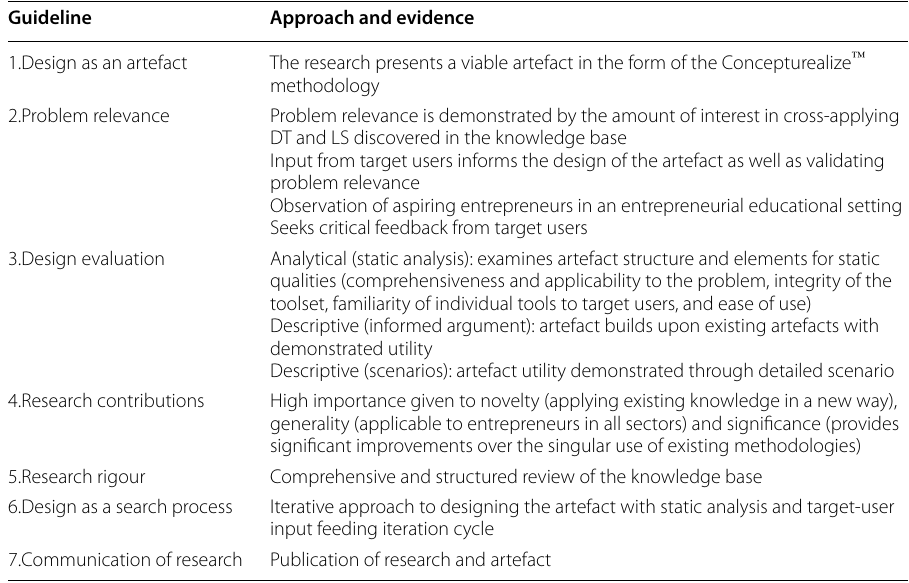
Table 2 Approach taken towards the design-science guidelines